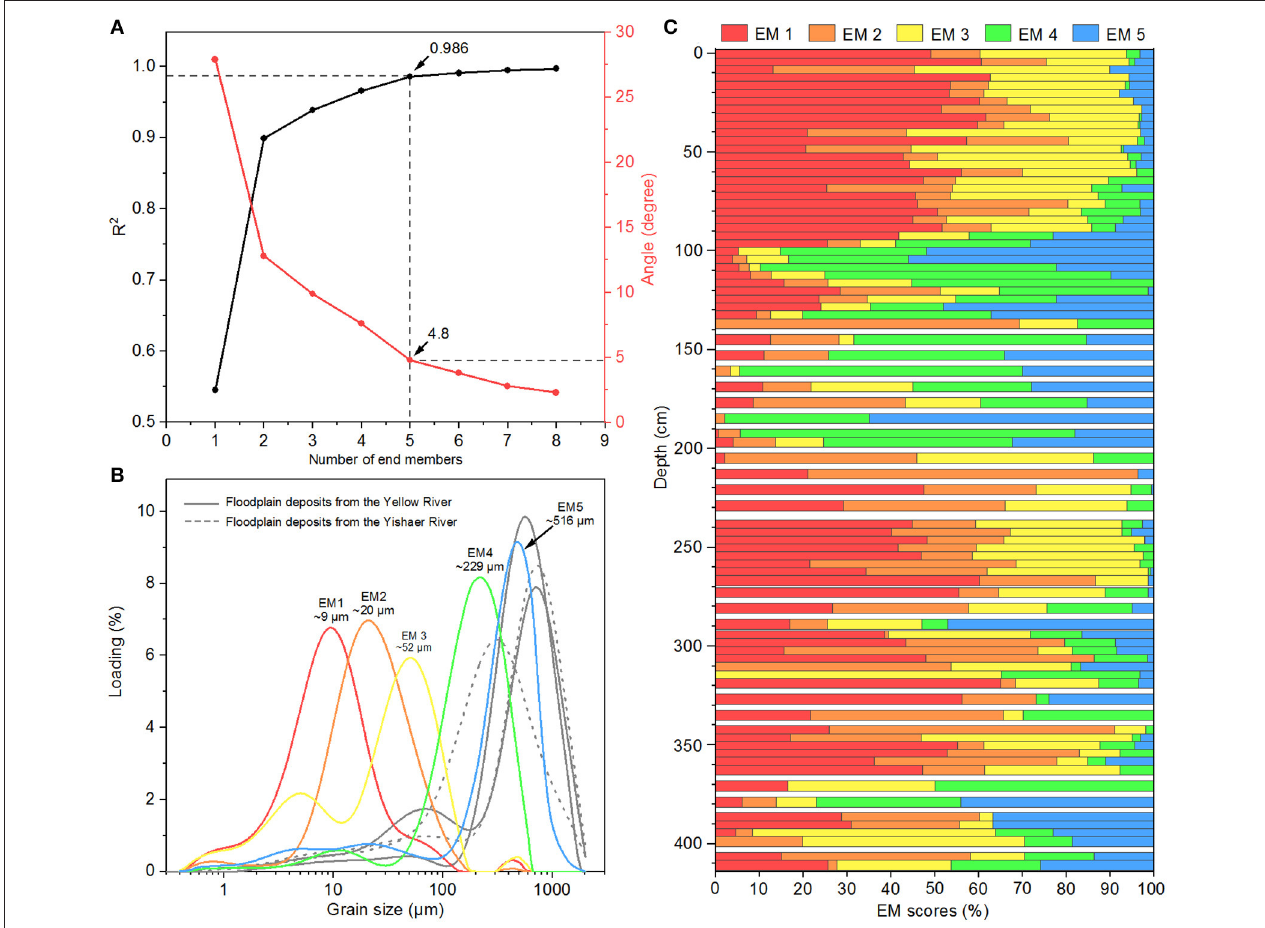
FIGURE 5 | Results of end-member modeling analysis (EMMA) for section T1406E and grain size (GS) frequency distribution curves for typical floodplain sediments. (A) Coefficients of determination ( R 2 ) and angular deviation of EMMA; (B) GS frequency distribution curve of End-Member (EM)1–5, and typical modern floodplain sediments of the Yellow River and Yishaer River; (C) Proportions of EM1–5.